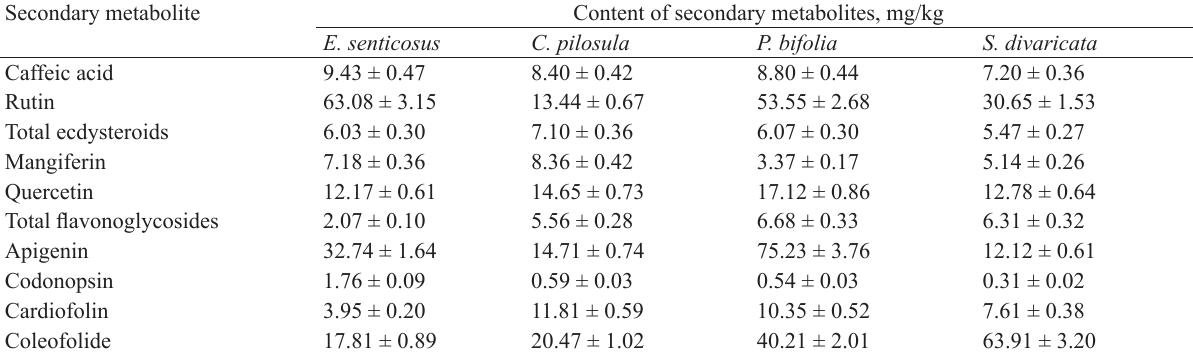
Table 4 Content of secondary metabolites in root extracts Secondary metabolite Content of secondary metabolites, mg/kg